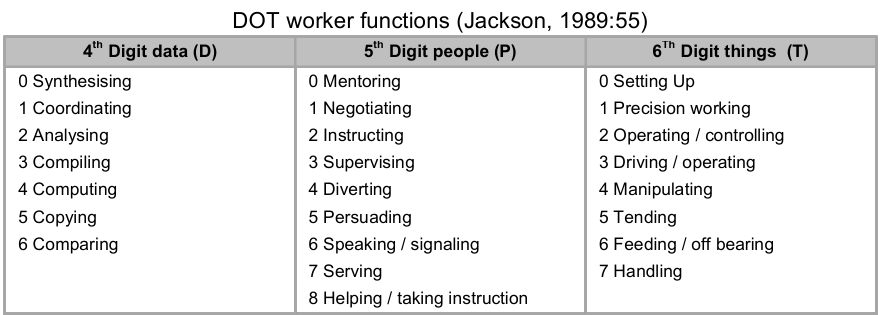
DOT worker functions (Jackson,